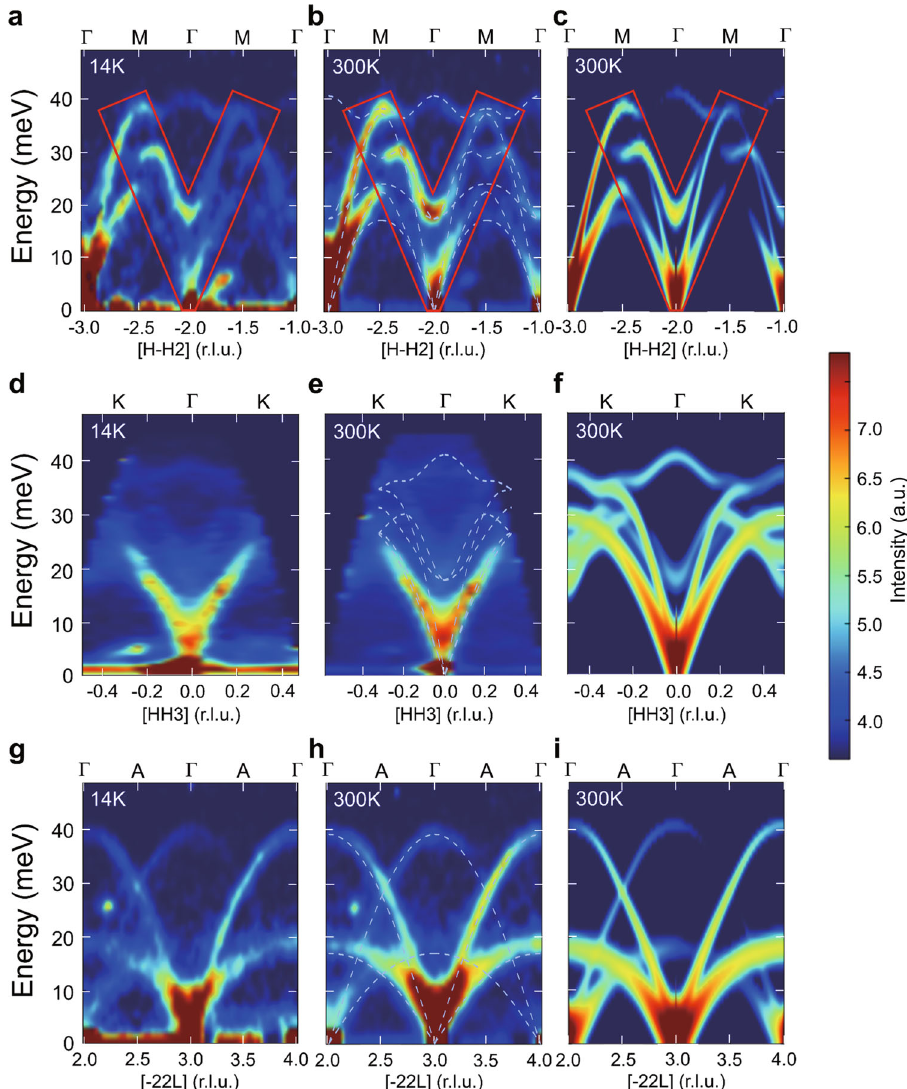
Fig. 2 Phonon dispersion nesting observed in the dynamical susceptibility χ ″ (Q, E) from inelastic neutron scattering (INS) measurements. a , b , c are the χ ″ ( Q , E ) for scattering wavevector Q along [H, – H, 2] (r.l.u.). d , e , f are the results along [H, H, 3]. a , d are the results at 14 K, ( b , e ) are the results at 300 K overlaid with the calculated phonon dispersion, and ( c , f ) are the calculated χ ″ ( Q , E ) at 300 K. The parallel sections were marked by the red boxes. g , h , i are the results along [ − 2, 2, L]. Small dots (( − 2, 2, 2) to ( − 1.5, 1.5, 2) along Γ ‒ M and around ( − 2, 2, 2.2) along Γ ‒ A) in the measured χ ″ ( Q , E ) are multiple scattering artifacts. Color bar indicates the phonon intensities plotted on a logarithmic